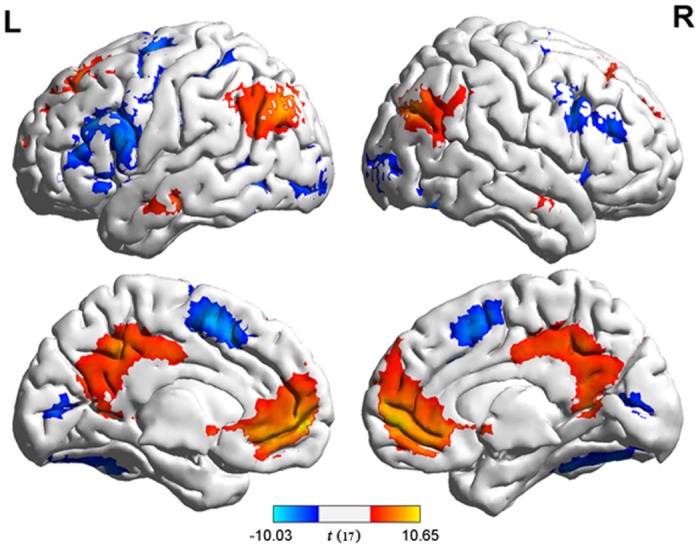
Results of comparisons between words and regular nonwords.Brain regions that demonstrated stronger activation to words are shown in warm color. Brain regions that demonstrated stronger activation to regular nonwords are shown in cold color. False positive rate was set at α < 0.05 (p < 0.001, k = 52) using REST AlphaSim.